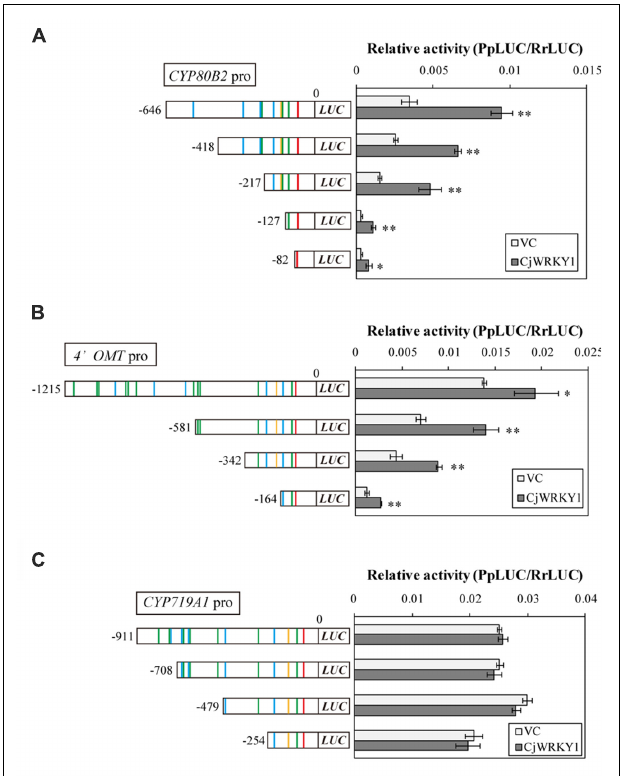
FIGURE 4 | Transactivation activity of CjWRKY1 in truncated CYP80B2 (A), 4 (cid:48) OMT (B), and CYP719A1 (C) promoter:: LUC reporter constructs. Effector plasmid vectors (35S:: GUS (vector control; VC) or 35S:: CjWRKY1 ) were co-transfected with reporter plasmid vectors containing deleted promoter regions into C. japonica protoplasts and relative LUC activities were measured by a dual-LUC reporter assay. The values are the average of three biological transfections, and the data are represented as the mean ± SD, ∗∗ p < 0.01, ∗ p < 0.05, Student’s t -test.